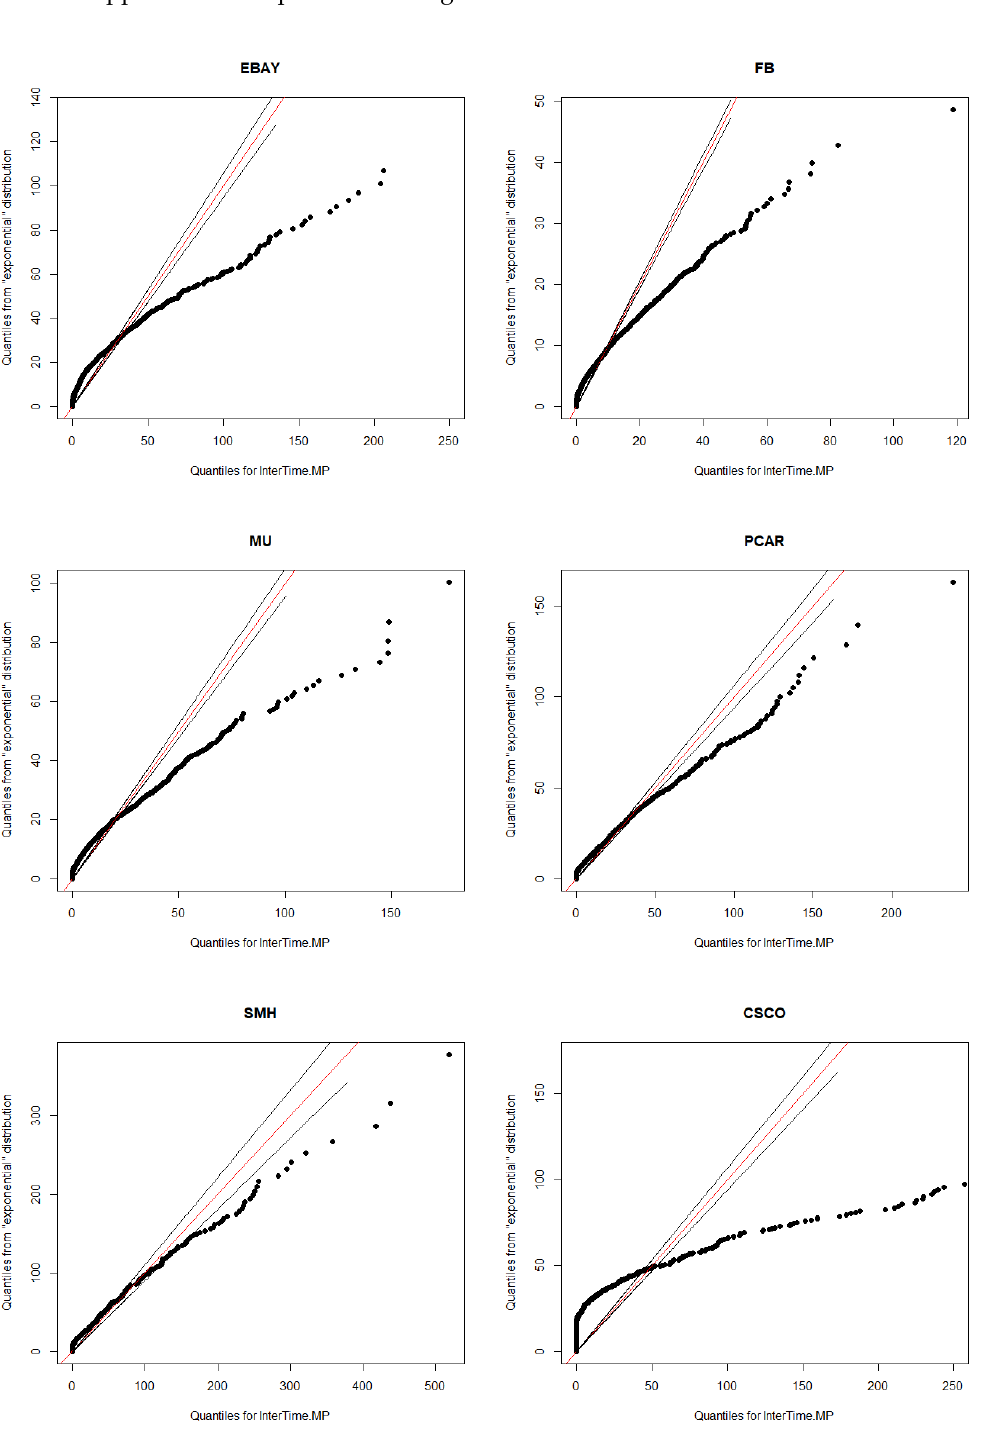
Figure 1. QQ-plot for 6 different